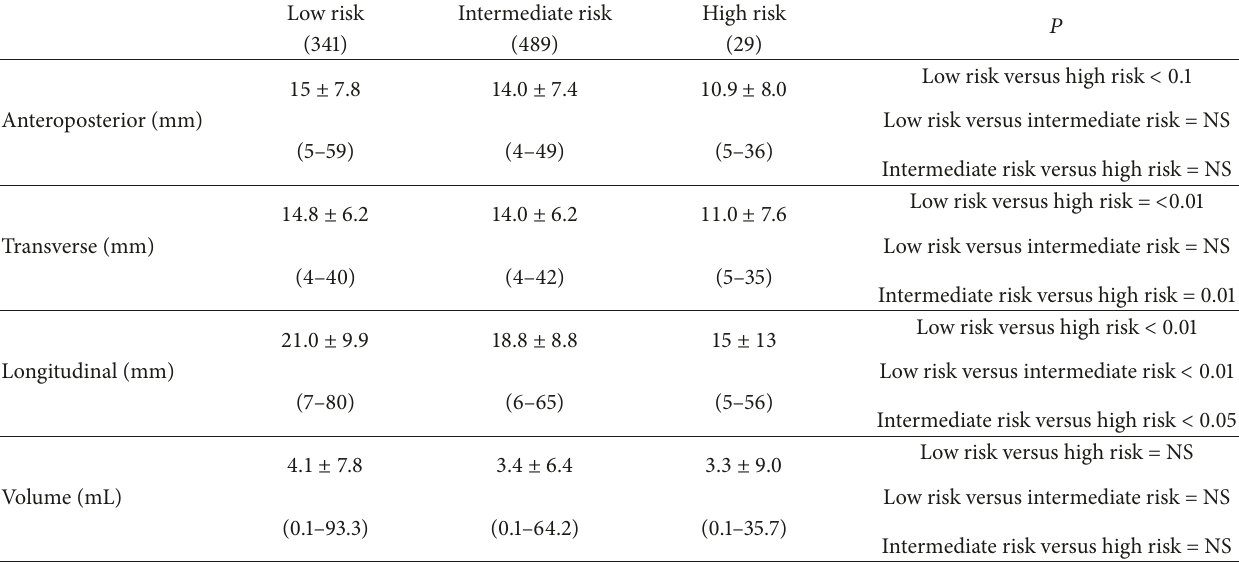
Table 1: Dimensions of nodules evaluated by fine needle aspiration, divided by ultrasound risk categories. Data are expressed as the mean ± SD.